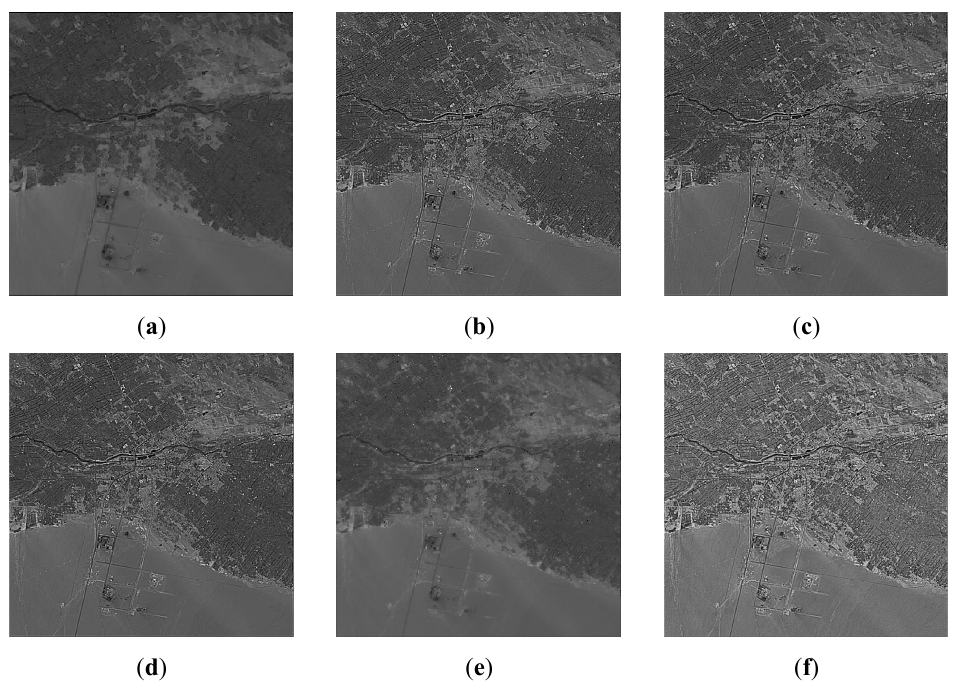
Figure 9. Enhanced image of data 3 by using our IDCP algorithm with: ( a ) Sobel; ( b ) Laplacian; ( c ) Yipufei [19]; ( d ) MGL [20]; ( e ) Wadhwa et al. [21]; ( f ) Proposed BFD.